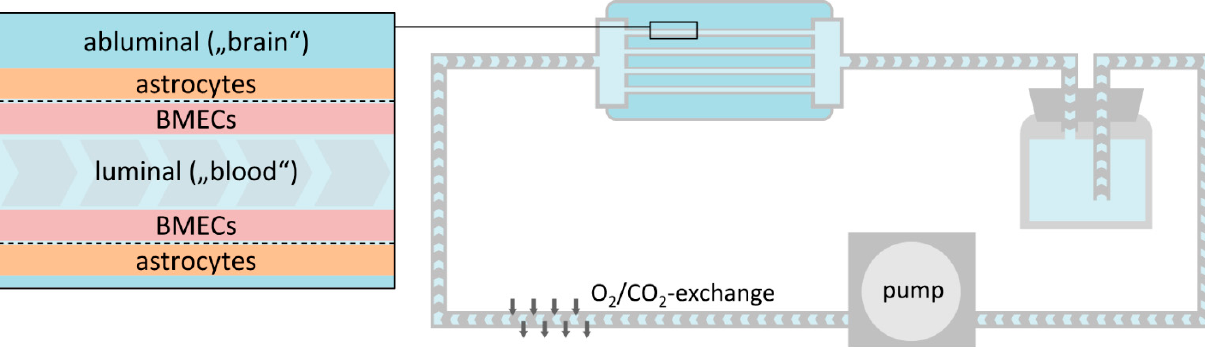
Figure 8. Dynamic in vitro (DIV) models of the blood–brain barrier (BBB). DIV BBB models use a variable-speed pulsatile pump to push culture medium through a co-culture of brain microvascular endothelial cells and astrocytes located in the inner and outer side of microporous hollow fibers respectively. The resulting shear stress simulates the effects of cerebral blood flow in vivo, thereby improving barrier function and expression of BBB-specific transporters when compared to static co-culture systems.